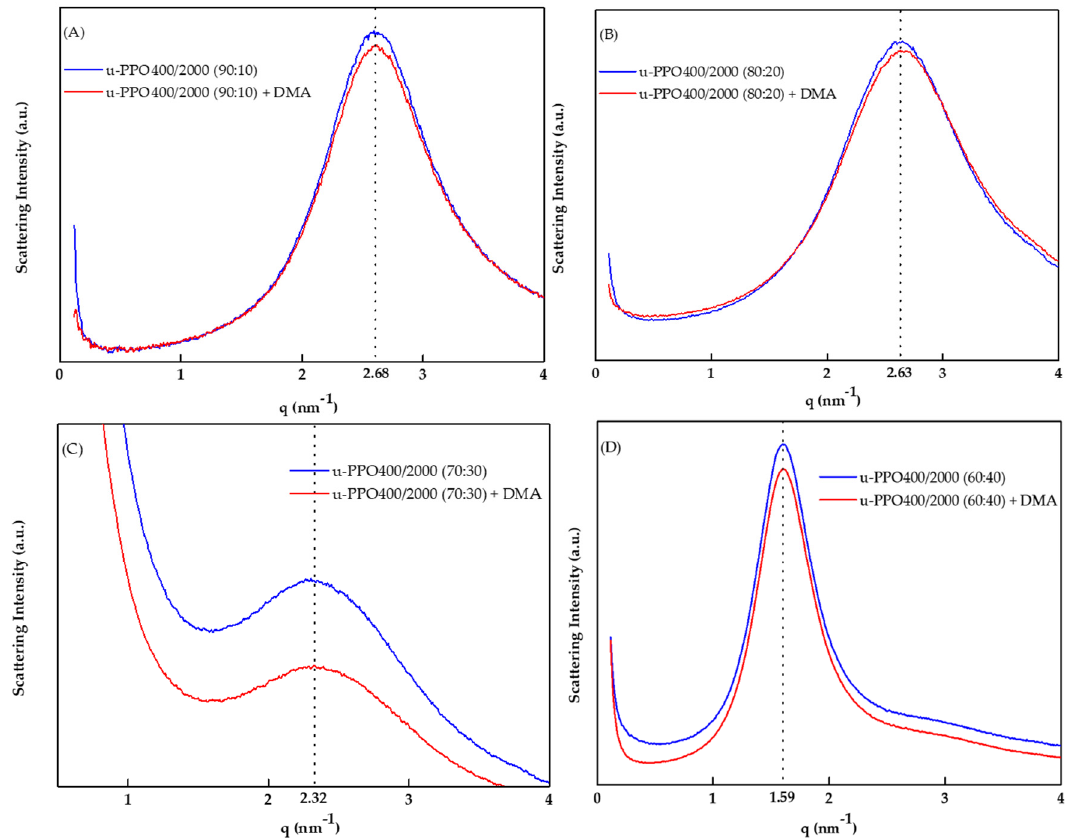
Figure 3. SAXS curves for ureasil–polyether membranes with and without dexamethasone. ( A ) u-PPO400/2000 (90:10), ( B ) u-PPO400/2000 (80:20), ( C ) u-PPO400/2000 (70:30), and ( D ) u-PPO400/2000 (60:40). All the red curves represent the membranes with dexamethasone and the blue curves represent the membranes without dexamethasone. Abbreviation: DMA = dexamethasone.